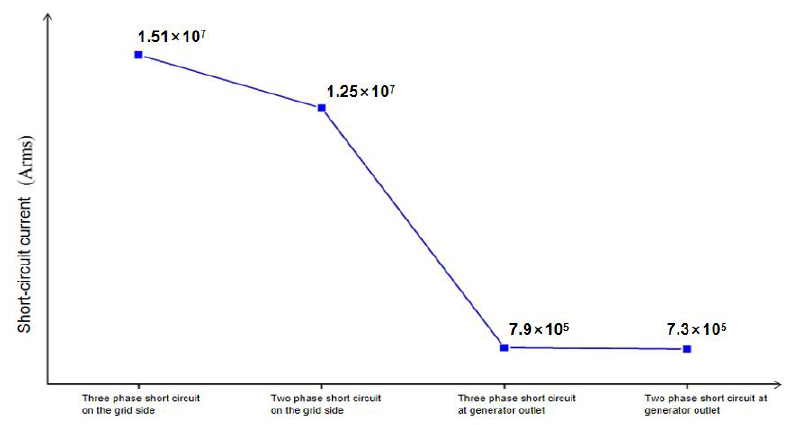
Figure 11. Maximum impulse current under different short-circuit faults.